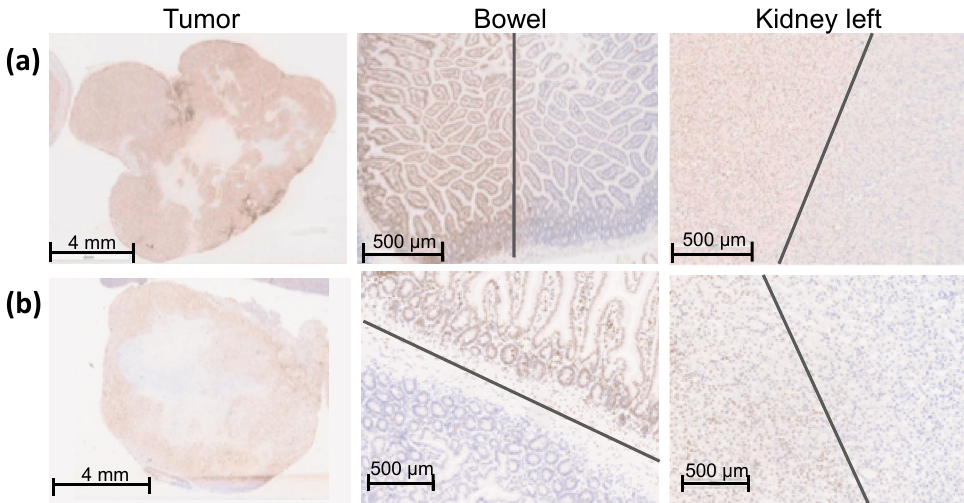
Figure 4. γ H2AX staining of an overview of the entire orthotopic pancreatic tumor, bowel, and left kidney one hour after SBRT with 25 Gy. The entire pancreatic tumor tissue shows an intense γ H2AX staining. The sharp gradient of the irradiation field is shown in both proximal OARS, the bowel, and the left caudal kidney, which were partly within the irradiation field. The grey lines mark the transition of the high-dose region to the low-dose region. ( a ) Representative Panc-1 tumor tissue and proximal OARs (bowel and left kidney); ( b ) Representative MiaPaCa-2 tumor tissue and proximal OARs (bowel and left kidney).